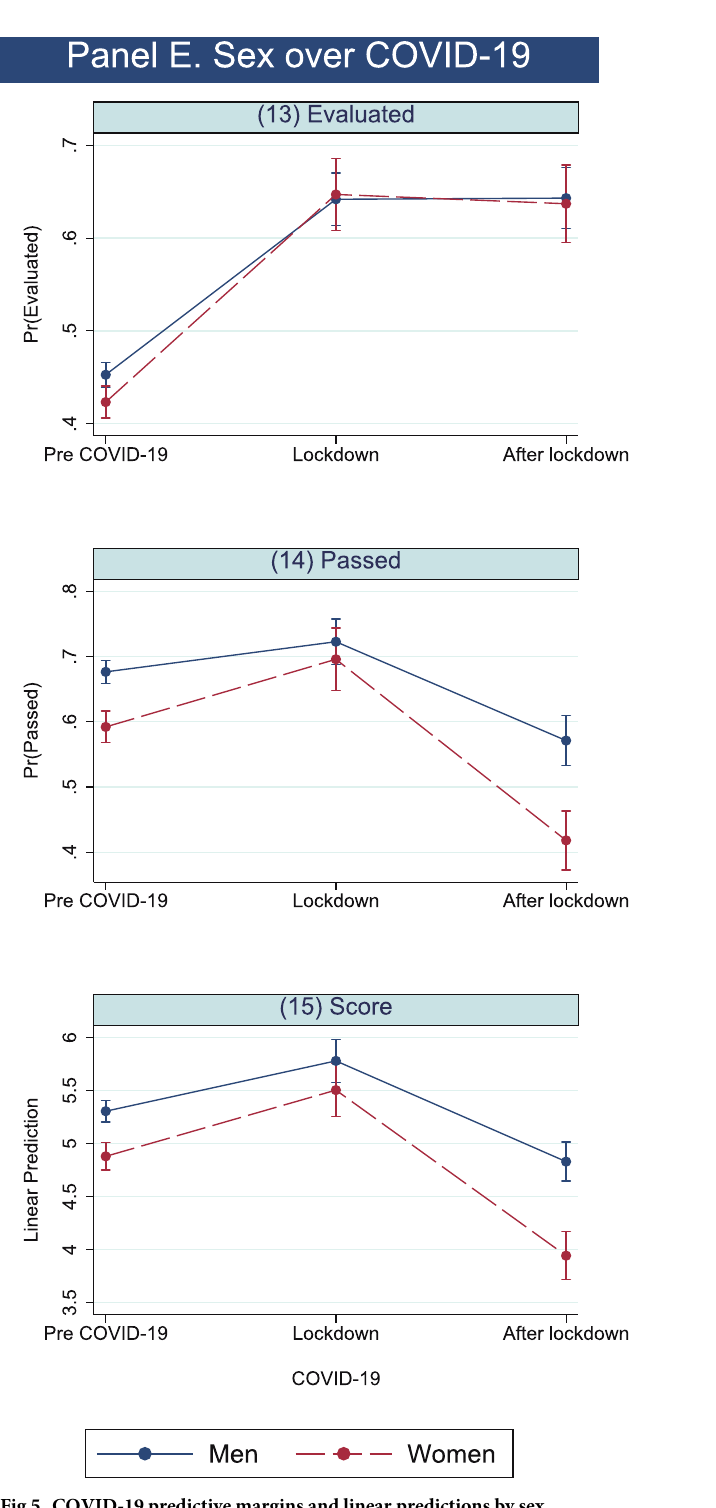
Fig 5. COVID-19 predictive margins and linear predictions by